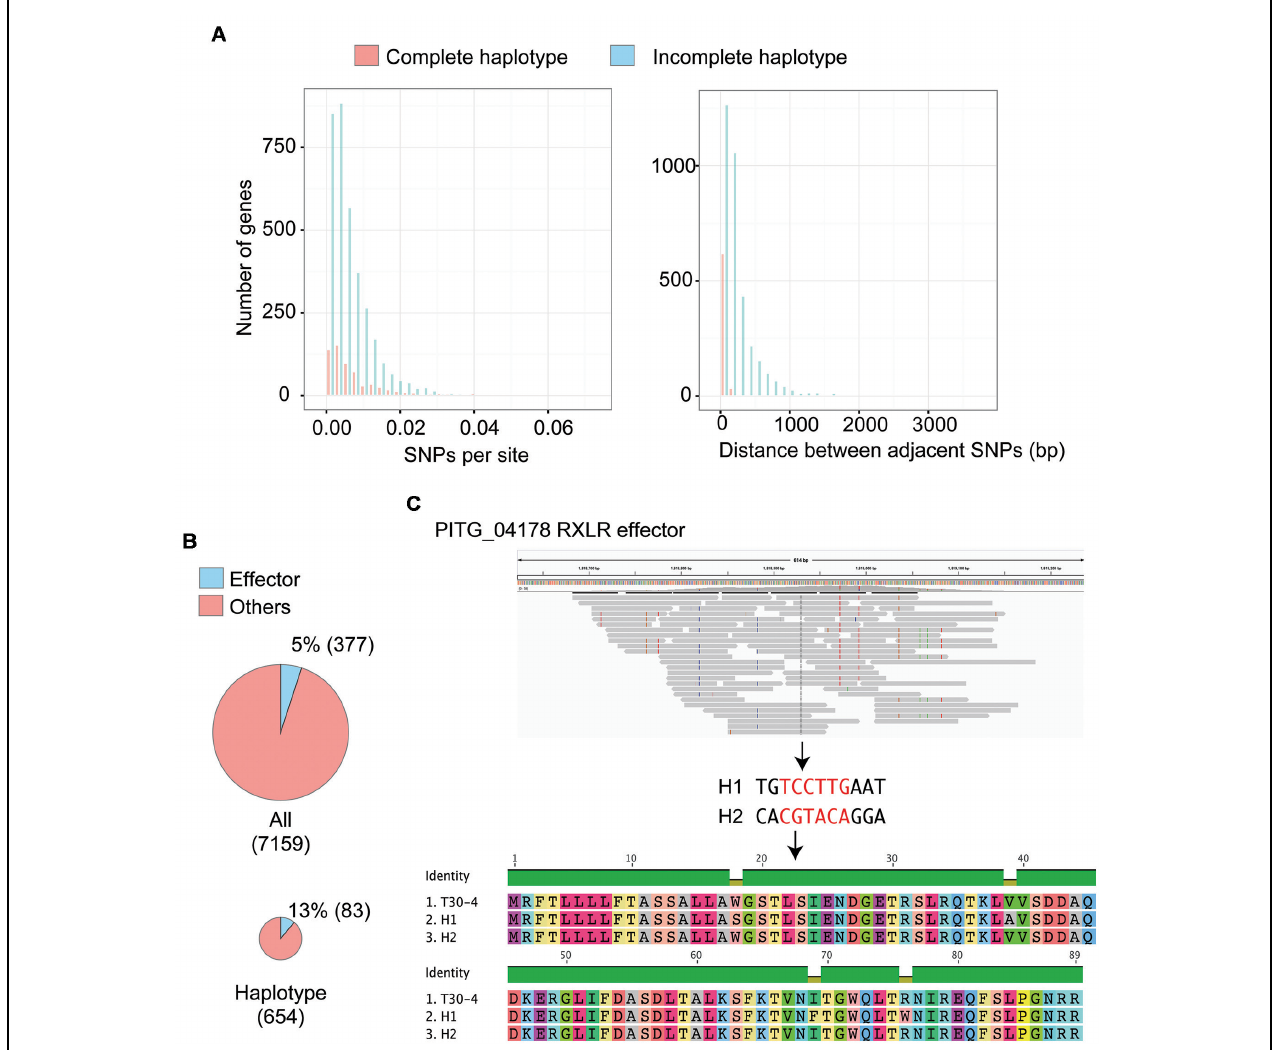
FIGURE 2 | Haplotype reconstruction of genes in 19th century Phytophthora infestans that was preserved in herbarium specimens. (A) Distributions of single nucleotide polymorphisms (SNPs) per site and physical distance between adjacent SNPs on the genome are shown. Red boxes indicate values for the genes with haplotypes completely reconstructed by linkSNPs software. Blue boxes indicate values for the genes with haplotypes that were not fully recovered. Genes harboring only a single SNP were not included. (B) Pie charts showing the number of genes encoding effectors out of the tested genes and the genes with haplotypes that were completely reconstructed. Genes encoding effectors were significantly enriched in the reconstructed haplotypes. (C) An example of RXLR effector genes with haplotypes that were successfully rebuilt. PITG_04178 encodes a secreted protein of unknown function containing an RXLR motif. The top image shows the pileup of short reads over the region where PITG_04178 is located using IGV viewer. Colored boxes in the pileup indicate heterozygous SNPs, which were used for haplotype reconstruction. The middle image shows two haplotypes reconstructed by linkSNPs. Red letters indicate nucleotides in the coding region. The bottom image is the alignment of amino acid residues of PITG_04178 that correspond to the modern isolate T30-4 and two haplotypes of 19th century P. infestans . One of the haplotypes was consistent with that of T30-4. The other had four amino acid